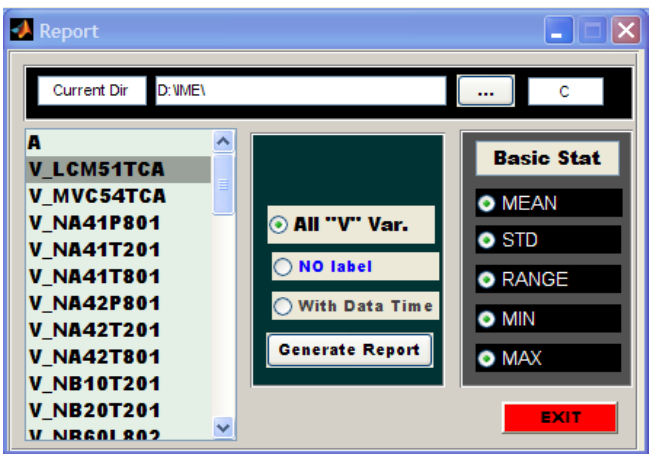
Figura 7. Interfaz para enlace de fichero Excel y selección de